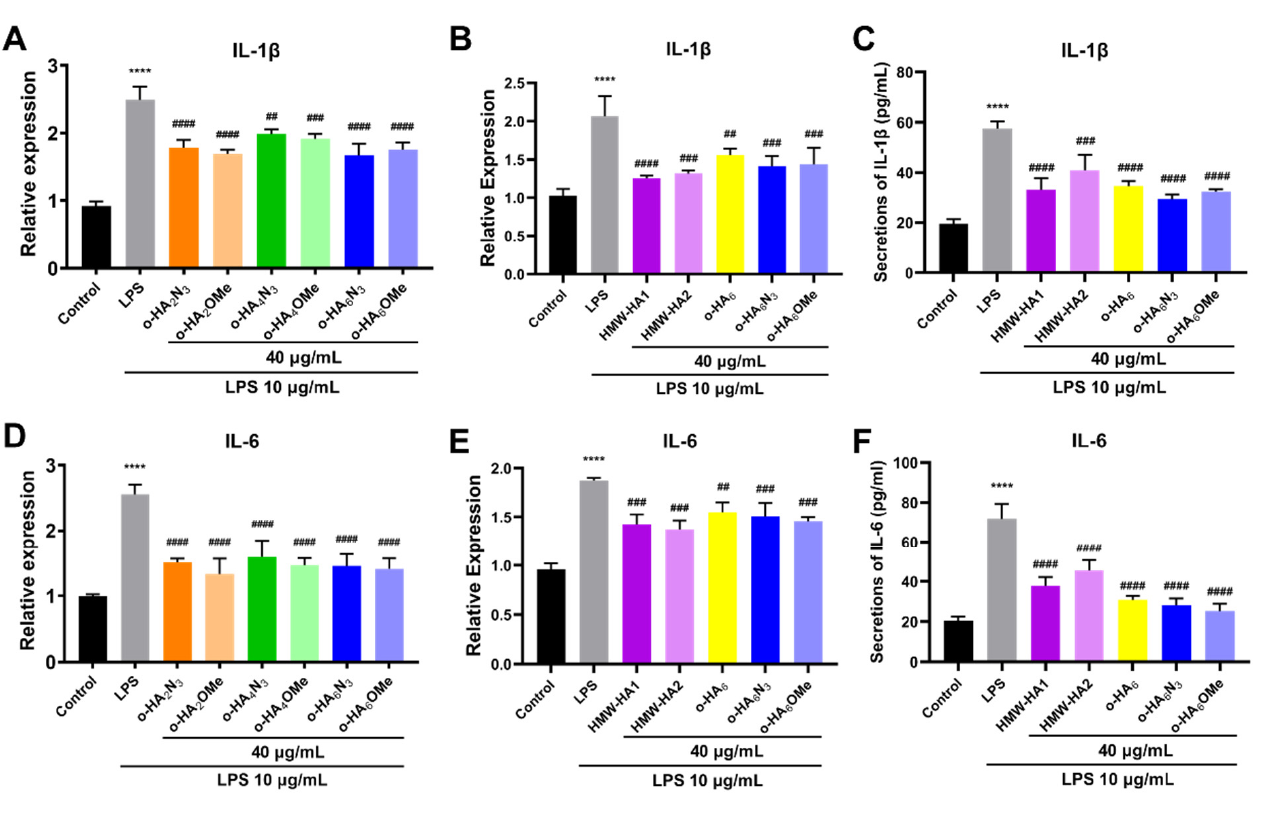
Figure 6. Effects of different HA derivatives on LPS-induced inflammatory responses in ATDC5 cells. ATDC5 cells in the LPS group were stimulated with LPS (10 µ g/mL) for 24 h and then cultured in a medium containing 10% FBS for another 24 h. For different HA derivatives groups, ATDC5 cells were treated with LPS (10 µ g/mL) for 24 h followed by treatment with corresponding samples (40 µ g/mL) for an additional 24 h, respectively. ( A – C ) IL-1 β mRNA expression levels and cytokine level were measured by RT-qPCR and ELISA. ( D – F ) IL-6 mRNA expression levels and cytokine level were measured by RT-qPCR and ELISA. **** p < 0.0001 vs. Control group; # p < 0.05, ## p < 0.01, ### p < 0.001, #### p < 0.0001 vs. LPS